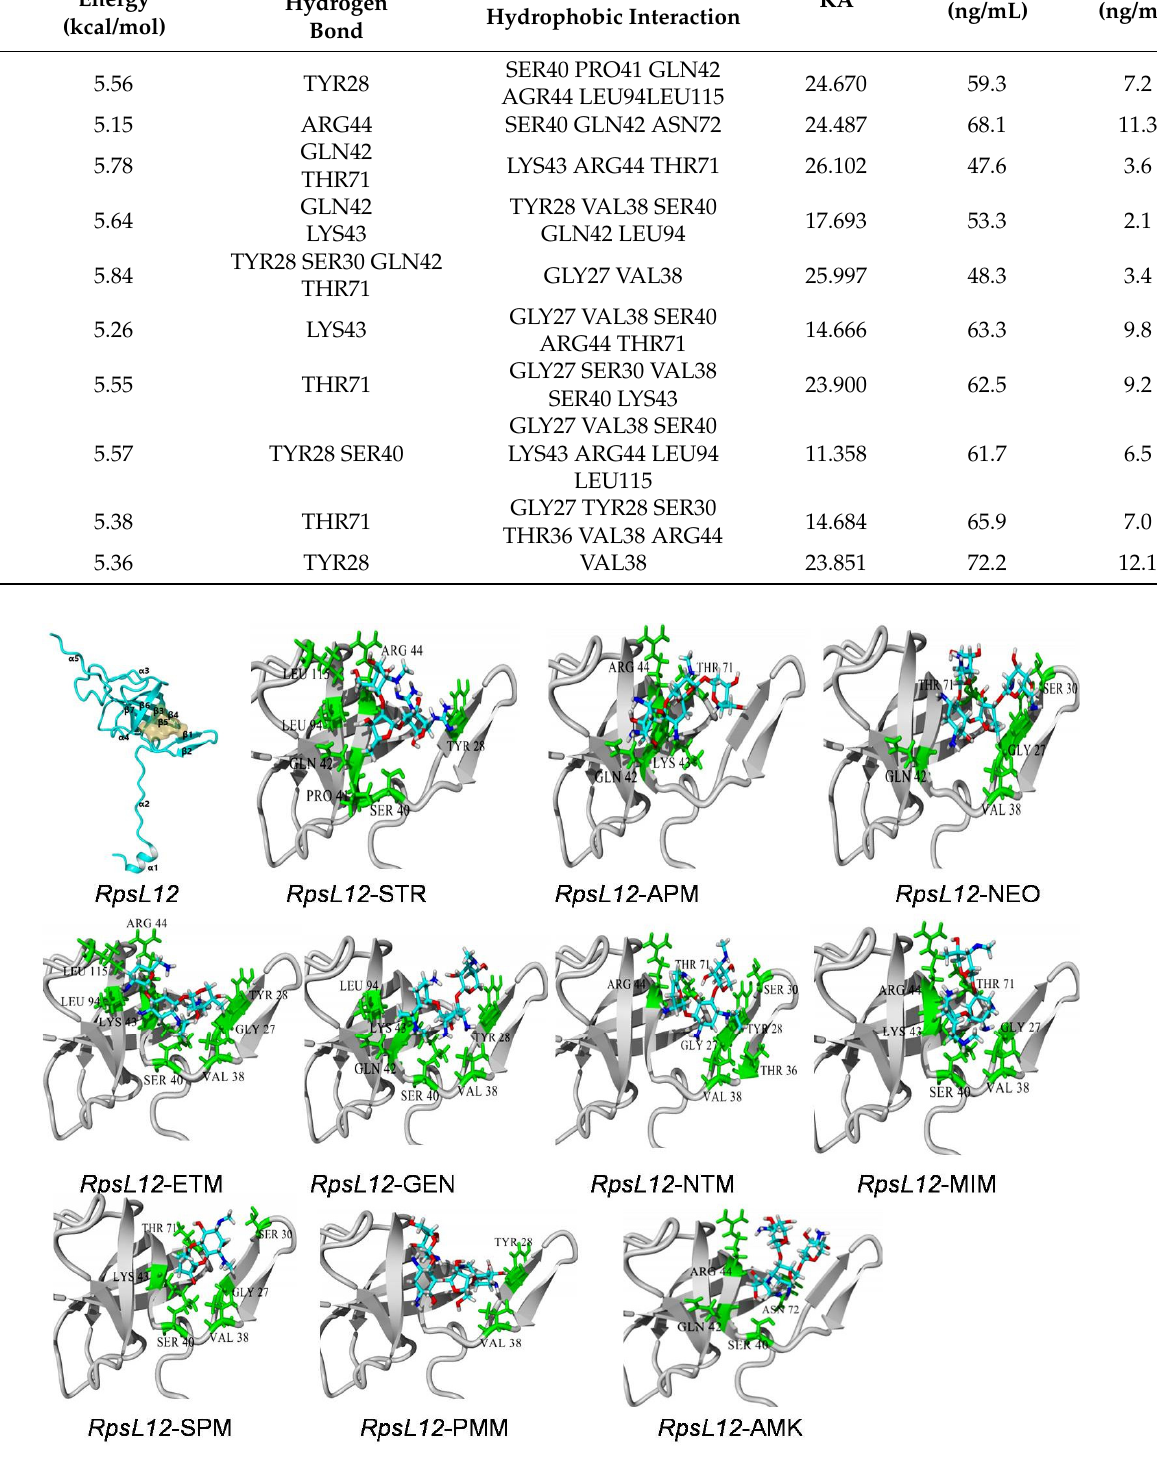
Figure 4. General conformation of RpsL 12 and the close-up view of its docking complexes with the 10